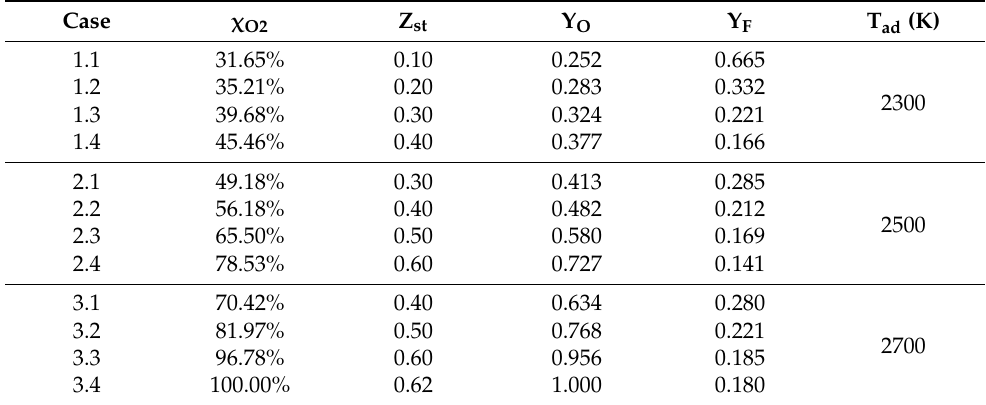
Table 1. Three groups of cases used in our numerical